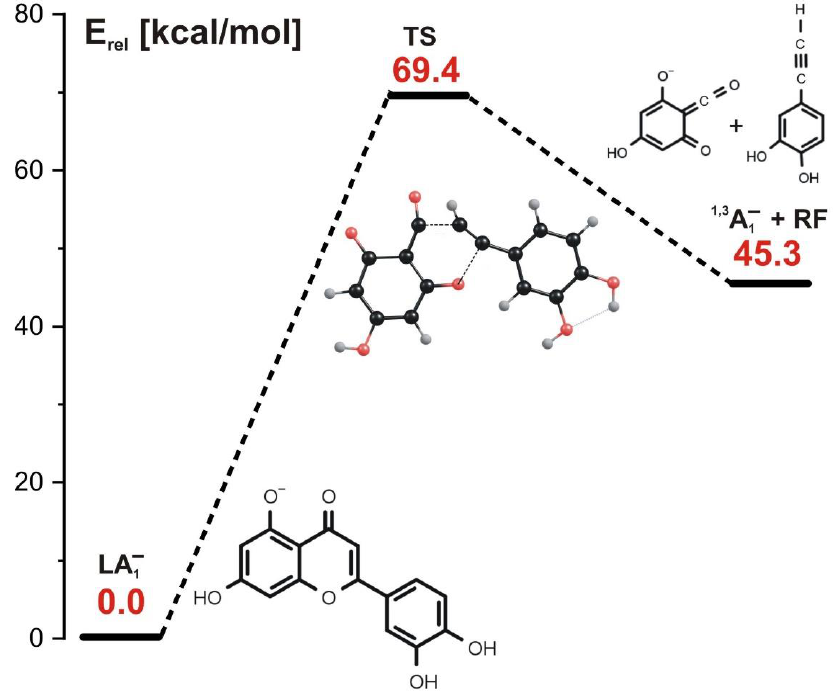
Figure 4. Energy profile for the 1,3-retrocyclization of LA 1 − proceeding according to the concerted mechanism and resulting in the formation of 1,3 A 1 − negatively charged product. The energies of the transition state (TS) and the separated products ( 1,3 A 1 − anion and the remaining neutral fragment RF) are given (in kcal/mol) as the relative values (E rel ) with respect to the energy of the LA 1 − substrate (taken as zero).